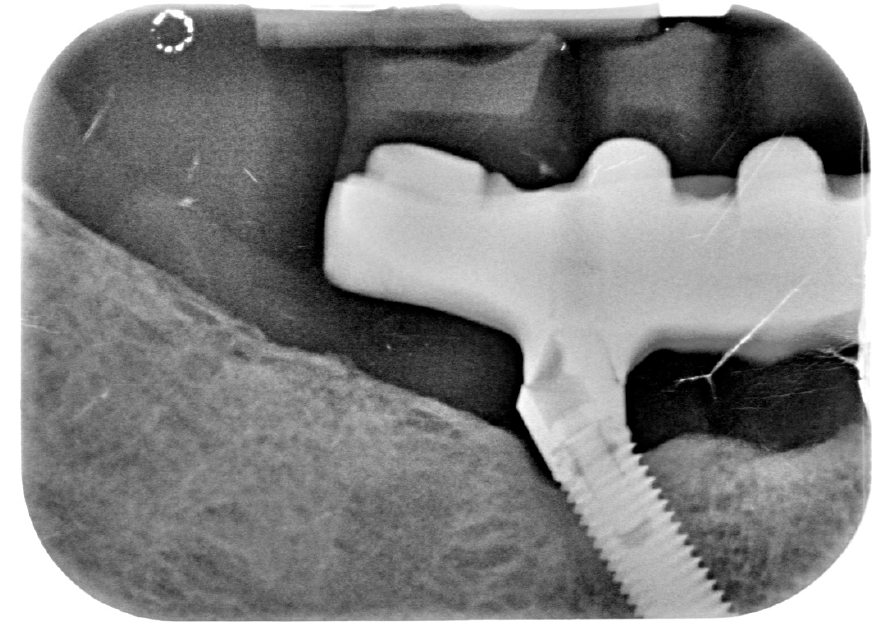
Figure 11. X-ray of 4.5 dental implant in patient before treatment.